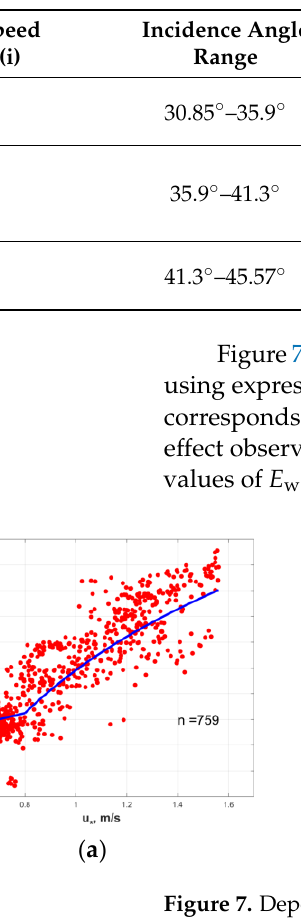
Table 4. The MADP-S1 power approximation coefficients for the friction velocity retrieval.